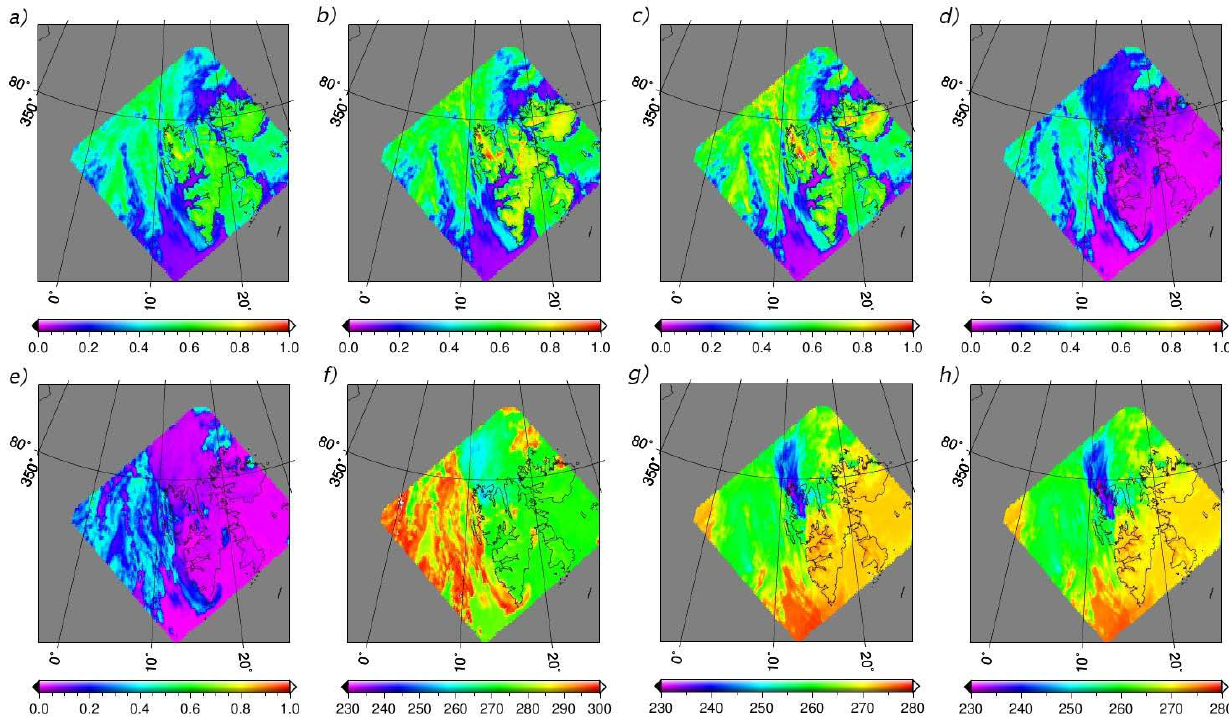
Fig. 1. AATSR scene for 3 May 2006, Spitsbergen, reflectance at 550nm (a) , 660nm (b) , 865nm (c) , 1600nm (d) , 3700nm (e) . Brightness temperature for 3.7 (f) , 10.8 (g) and 12µm (h)